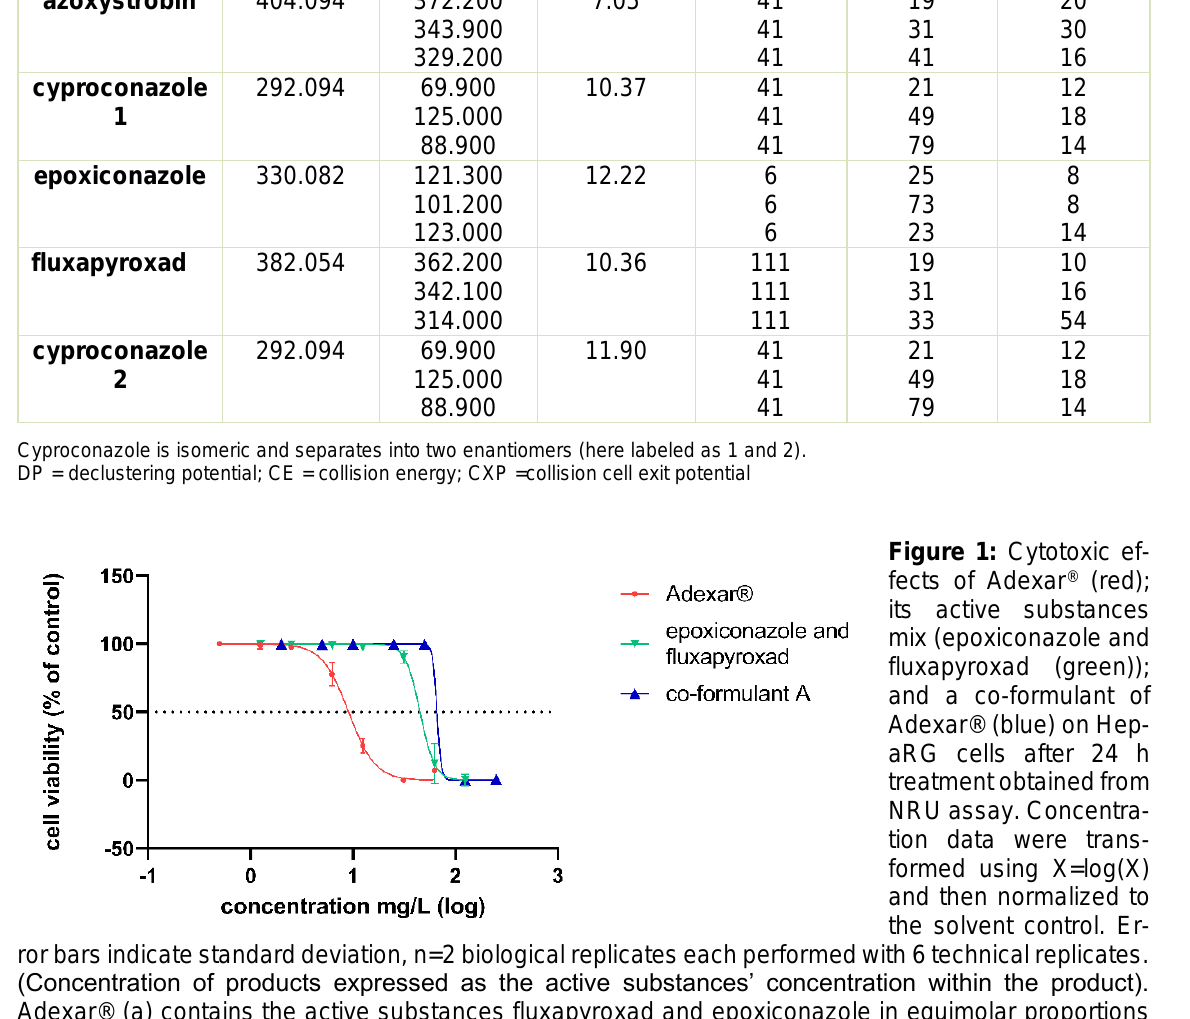
Table 2: Parameters of detection analyte